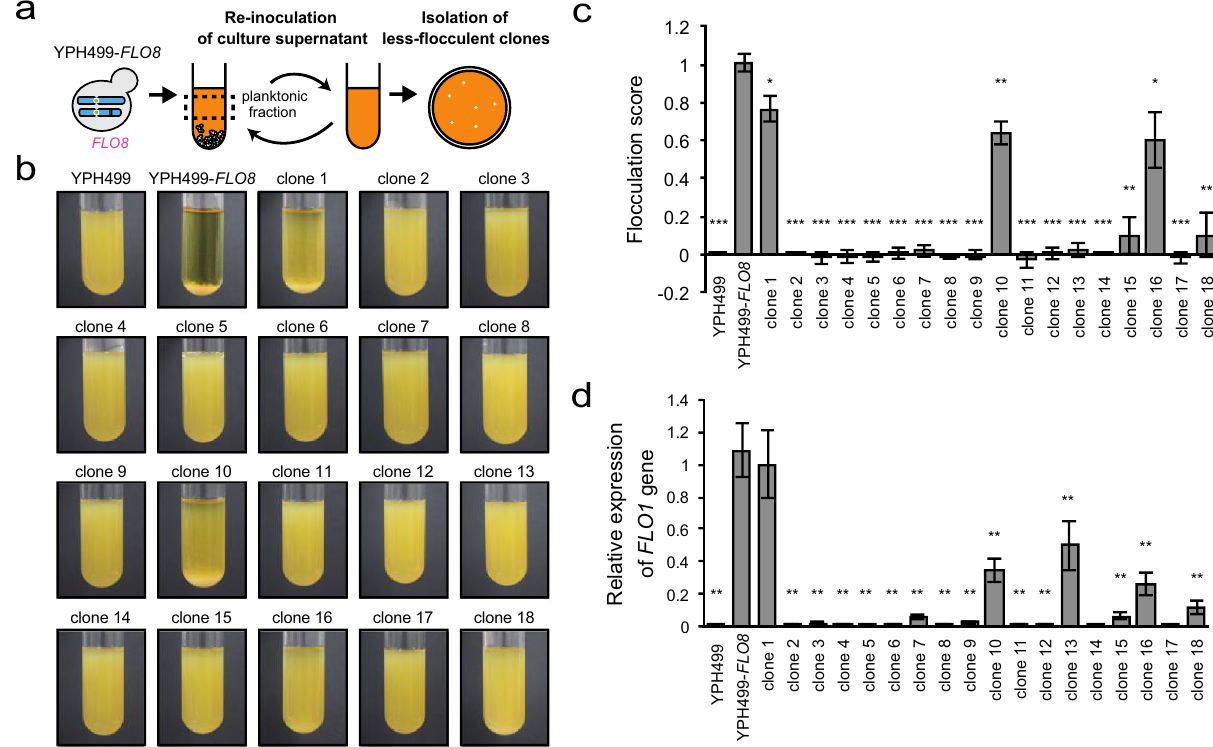
Figure 4. Altered flocculation phenotypes by re-inoculation of culture supernatant. ( a ) A schematic of serial transfer experiment. YPH499 cells expressing the wild-type FLO8 gene derived from the S799 strain (YPH499- FLO8 ) are cultured for 24 h and culture supernatant was re-inoculated into a new medium. This manipulation was repeated for 20 days, followed by single colony formation on the agar plate. ( b ) Flocculation behaviors of YPH499, YPH499- FLO8 , and less-flocculent clones isolated by serial transfer experiments. ( c ) Flocculation scores of YPH499, YPH499- FLO8 , and less-flocculent clones. P values were calculated using the Welch’s t -test compared to YPH499- FLO8 : * P < 0.05, ** P < 0.01, and *** P < 0.001. Error bars represent standard deviation ( n = 3). ( d ) Relative expression of FLO1 genes in YPH499, YPH499- FLO8 , and less-flocculent clones. FLO1 expression is measured by RT-qPCR and normalized to the expression of ACT1 gene. P values were calculated using the Welch’s t -test compared to YPH499- FLO8 : ** P < 0.01, and *** P < 0.001. Error bars represent standard deviation ( n =